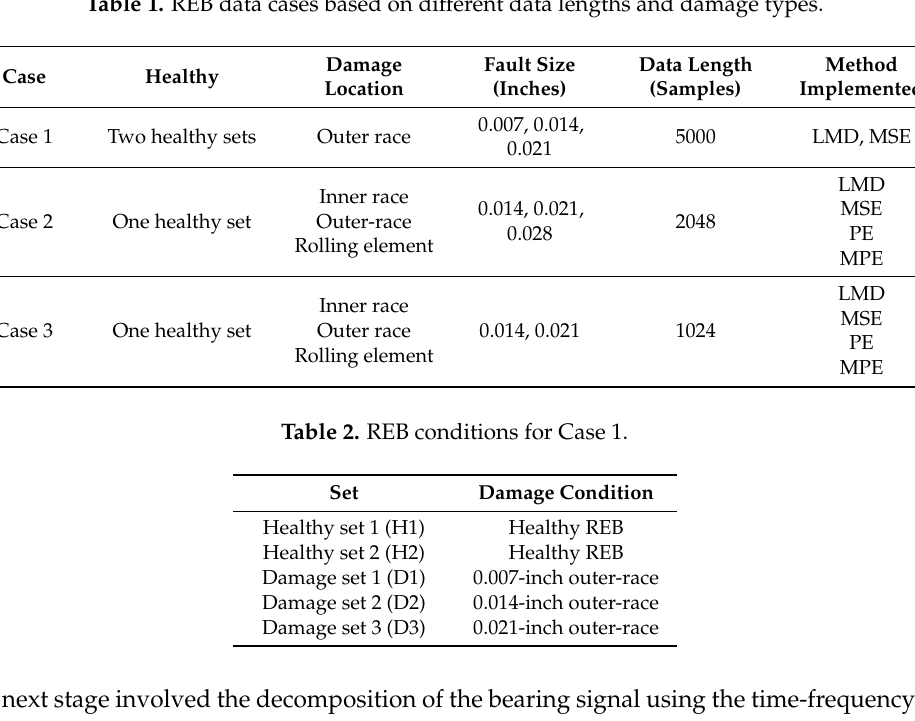
Table 1. REB data cases based on different data lengths and damage types.